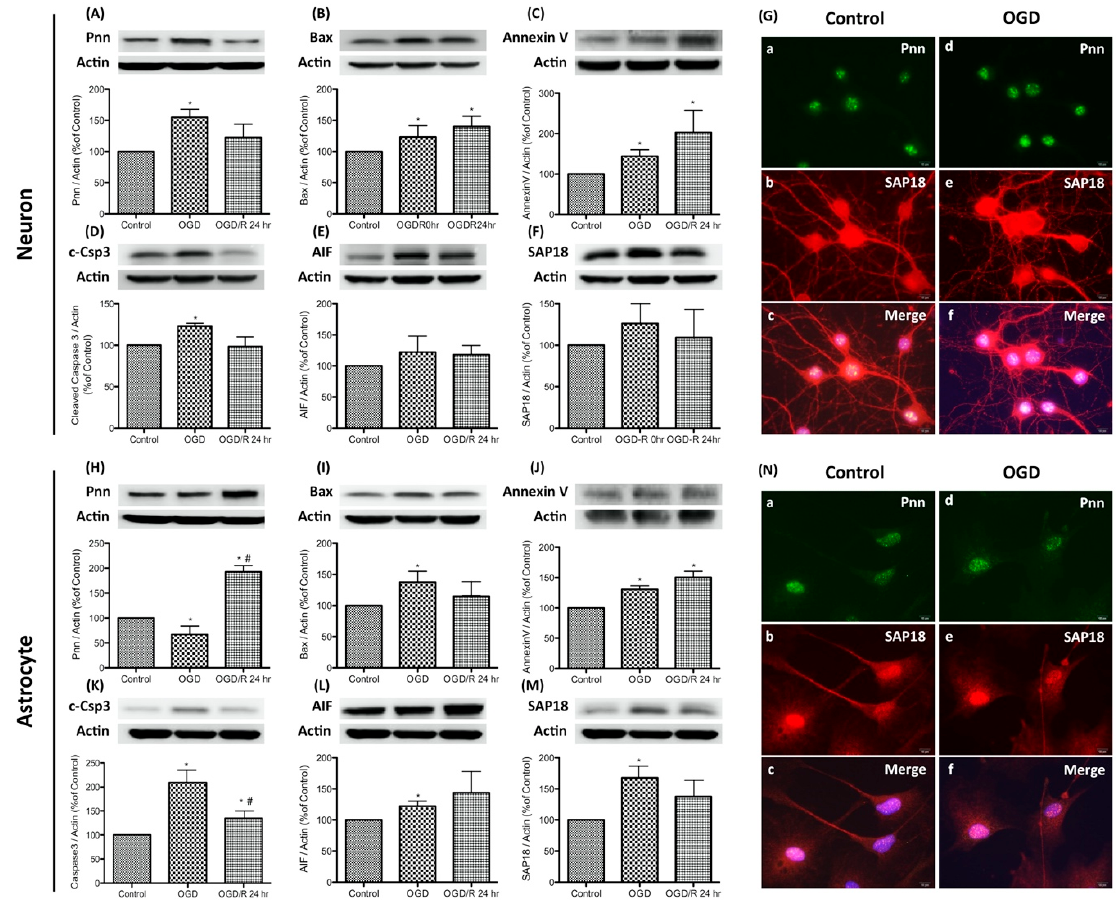
Figure 1. Expression and distribution of Pinin (Pnn) in primary cultured neurons and astrocytes with oxygen-glucose deprivation and reoxygenation. Western blotting was used to examine the protein expression of Pnn, histone deacetylase complex subunit (SAP18), and apoptosis-associated proteins (Bax, cleaved caspase-3, annexin V, caspase-independent apoptosis-inducing factor (AIF)) in neurons ( A – F ) and astrocytes ( H – M ) with oxygen-glucose deprivation and reoxygenation. Immunofluorescent stainings were used to examine the distribution of Pnn and SAP18 in neurons ( G ) and astrocytes ( N ) with oxygen-glucose deprivation. OGD, oxygen-glucose deprivation; OGD / R, oxygen-glucose deprivation and reoxygenation; AIF; caspase-independent apoptosis-inducing factor. * indicates p < 0.05 in comparison with control group; # indicated p < 0.05 in comparison with OGD group; n = 6 for each group. ( G and N ) scale bars in left lower corner of indicate 10 μ m.